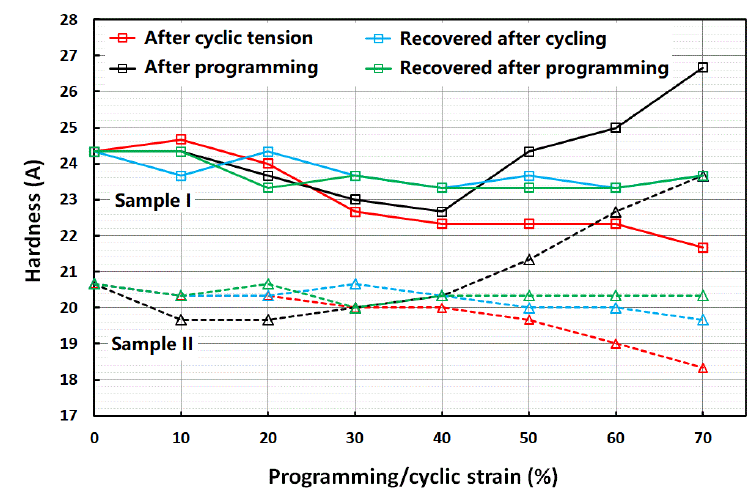
Figure 6. Shore hardness (average) of the top surface of strip samples. Red: after cyclic tension; blue: recovered after cycling; black: after programming; blue: recovered after programming.